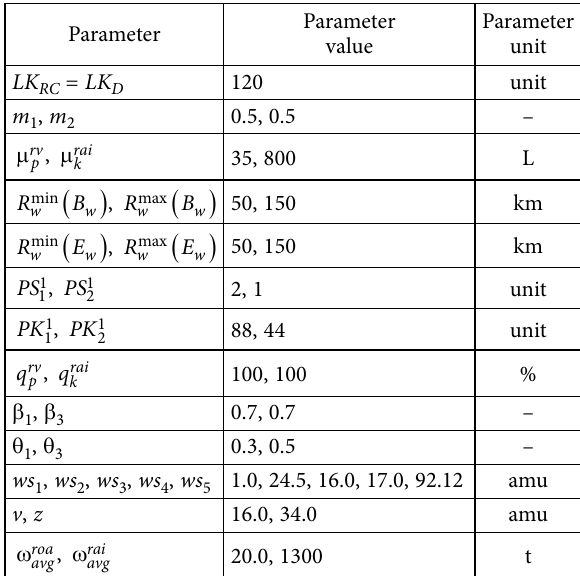
Table 2. Input data for